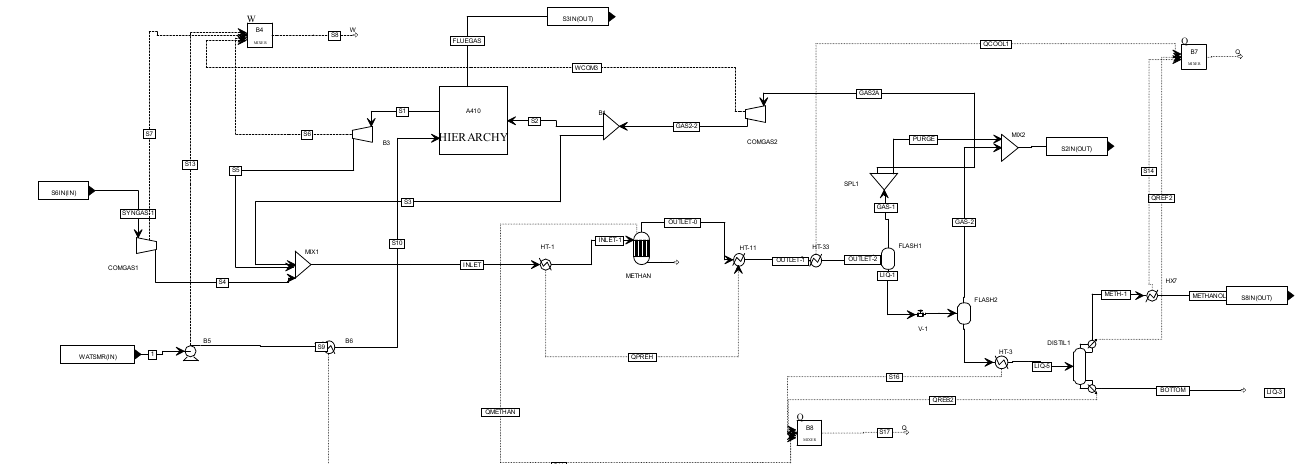
Figure A5. Aspen flowsheet of the methanol synthesis model .